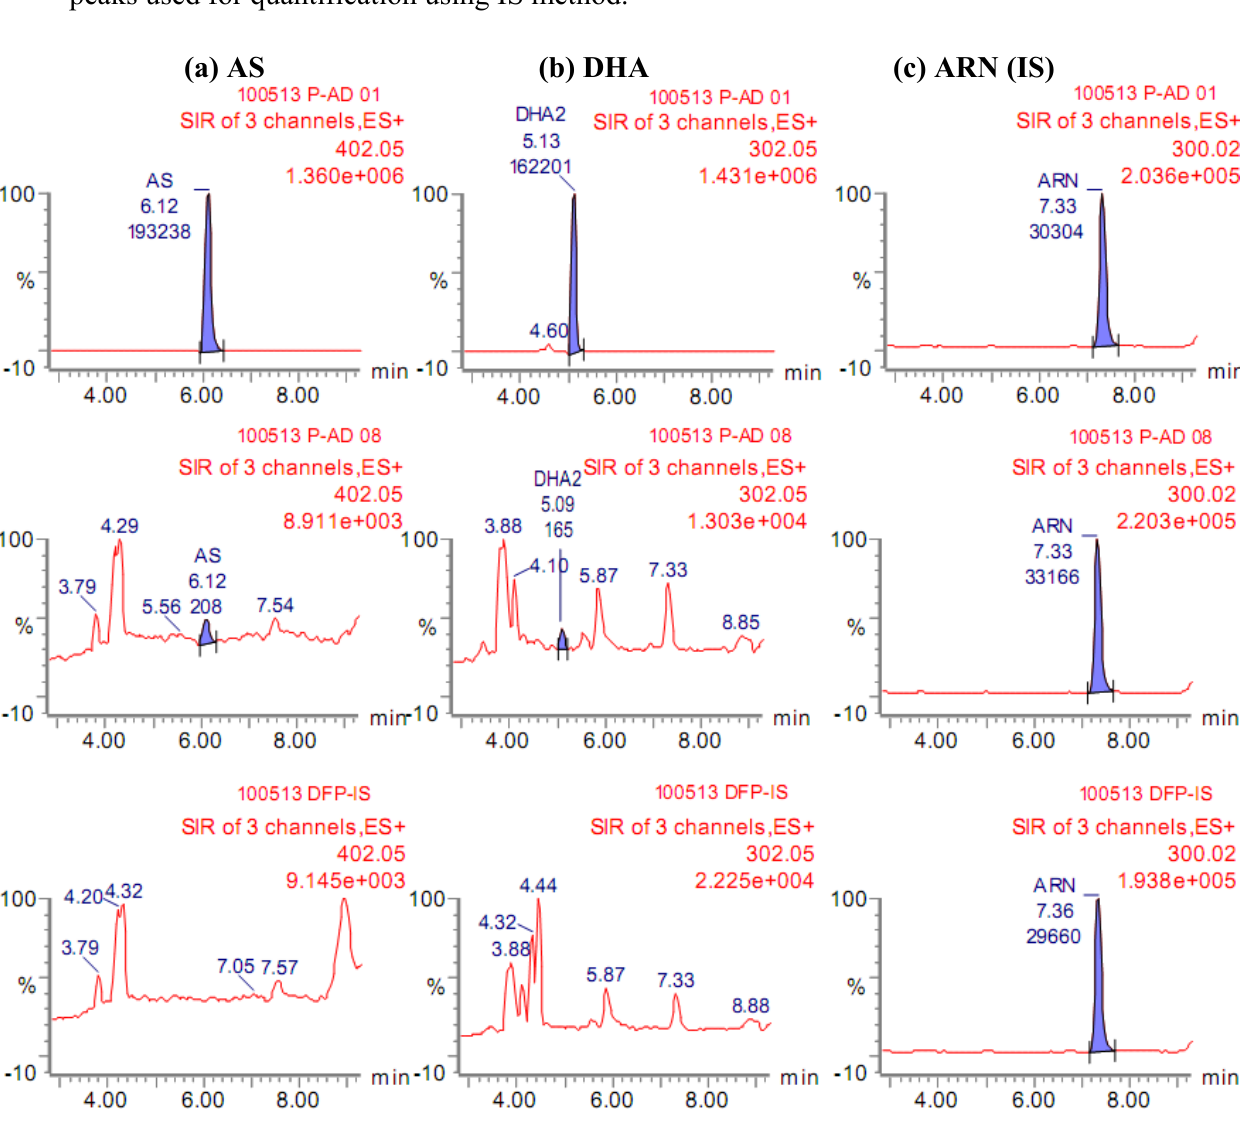
Figure 2. Representative chromatograms of (bottom) drug-free plasma, (middle) AS/DHA 3.20/5.33 nM at LLOQ and (top) 3,000/5,000 nM at ULOQ of ( a ) AS and ( b ) DHA spiked in plasma with ( c ) ARN 600 nM as internal standard (IS). Shaded areas indicate specific peaks used for quantification using IS